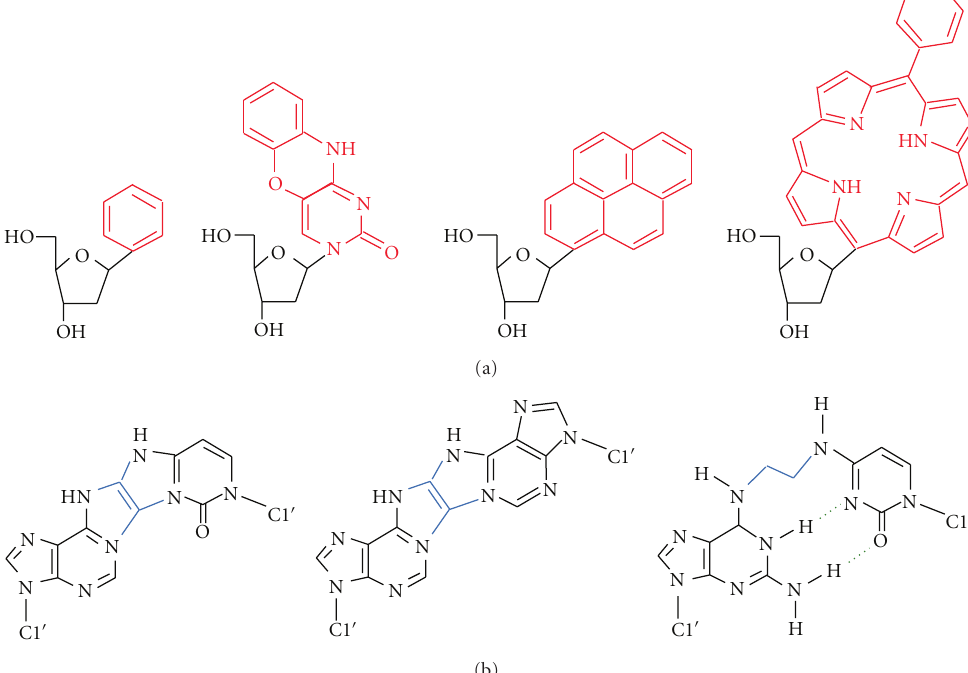
Figure 2: (a) Structures of unnatural nucleosides as a base analog with an aromatic hydrocarbon group in place of the purine and pyrimidine bases. (b) Structures of the base pair analogs that provide the interstrand crosslinking sites. The covalent bonds linking the nucleic acid bases are highlighted in